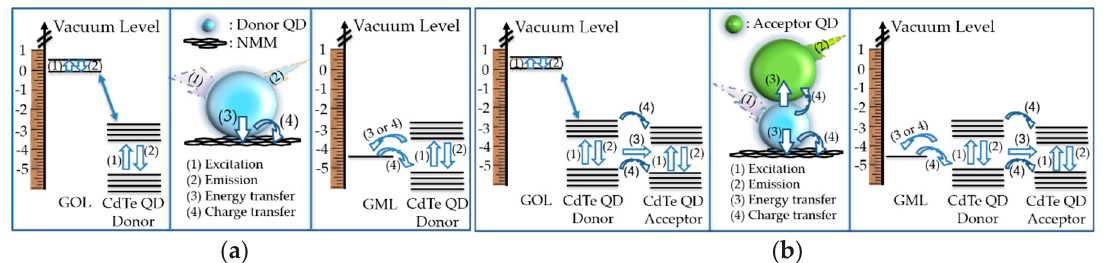
Figure 6. Energy level of the materials with the proposed mechanism for the relationship between: ( a ) donor CdTe and GOL, and donor CdTe and GML; ( b ) (donor CdTe attached on GOL) and (donor CdTe coated glass), and (donor CdTe attached on GOL) and (donor CdTe coated glass).